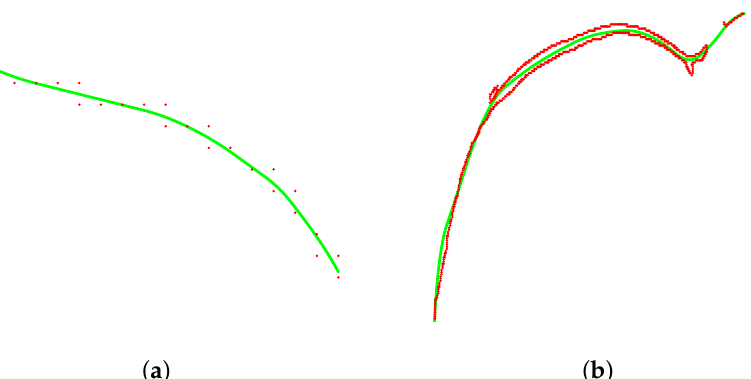
Figure 13. Example of local tubular neighborhoods (in red) and their approximations (in green): ( a , b ) are taken from Figures 9 and 13, respectively.